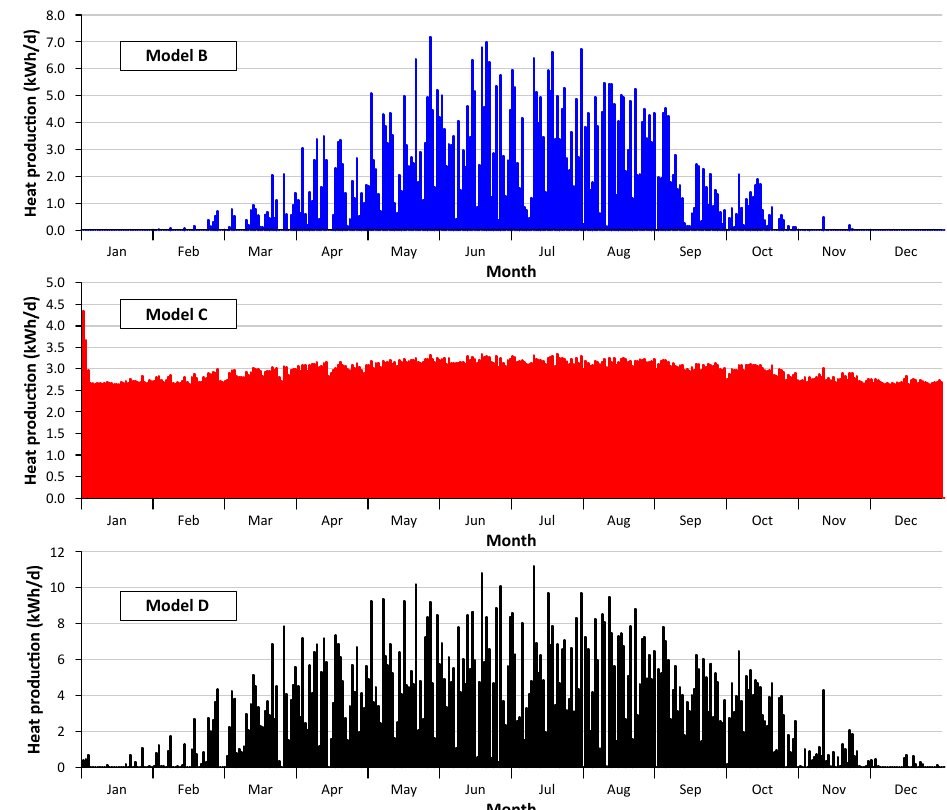
Figure 7. Annual variability of daily heat production by PV-T in the considered models.